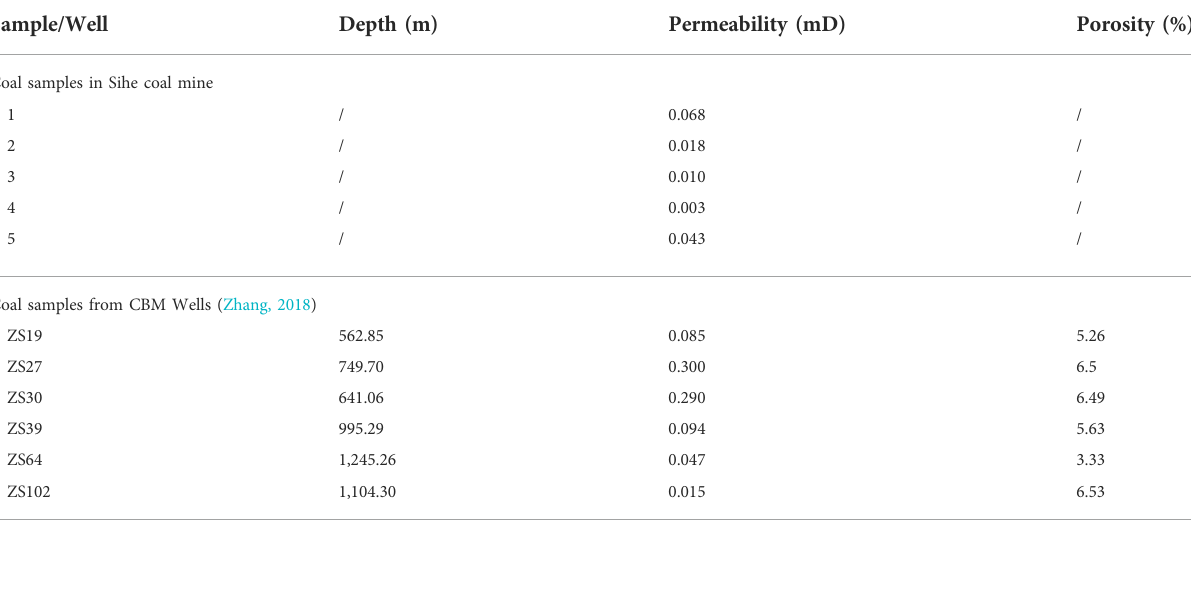
TABLE 2 Permeability and porosity of coal samples in Zhengzhuang block.